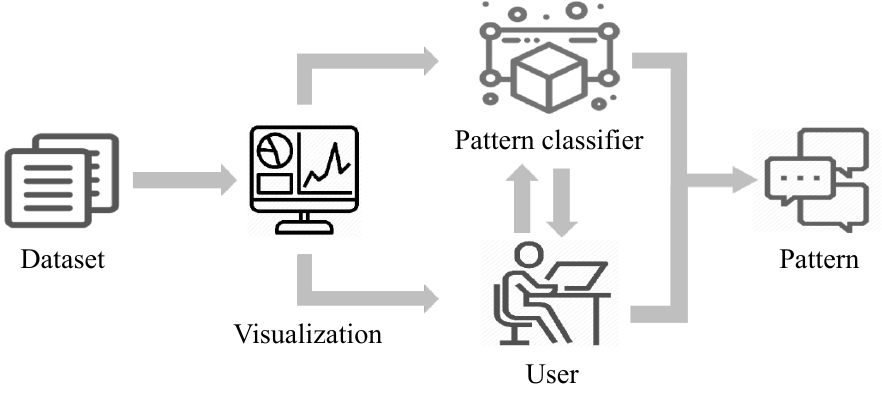
Figure 2. Scenarios for applying pattern classifiers for automated data